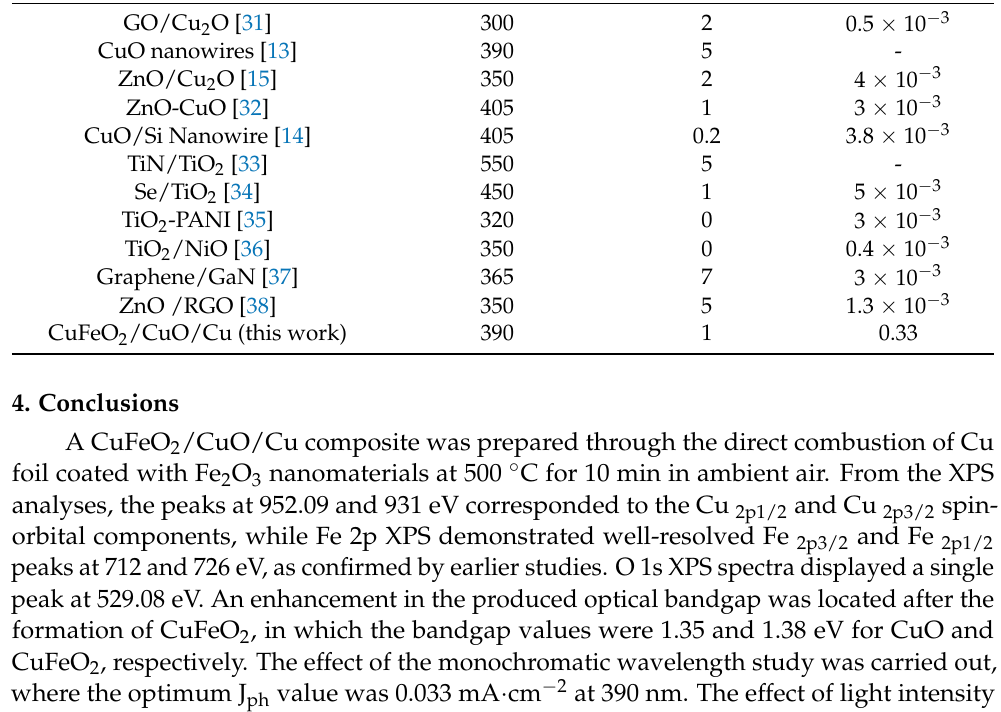
Figure 9. The schematic diagram for the optoelectronic mechanism of CuFeO 2 /CuO/Cu electrode. Table 1. Comparison of the produced results with the previous literature.